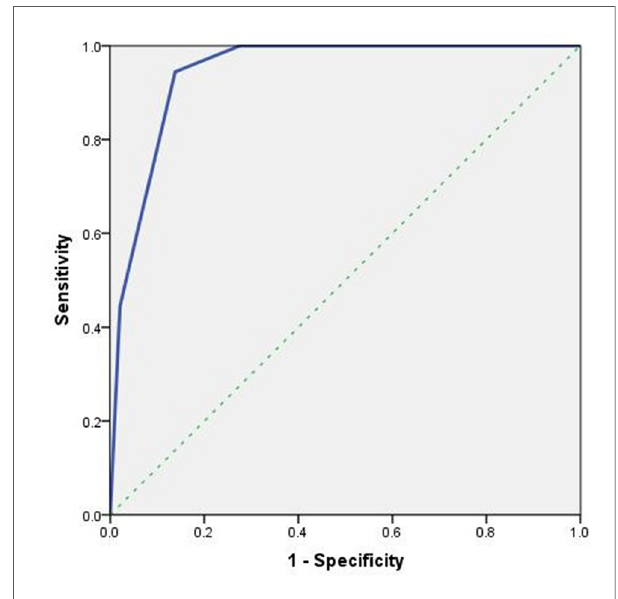
FIGURE 1 Receiver operating characteristic (ROC) curve analysis of O-RADS.